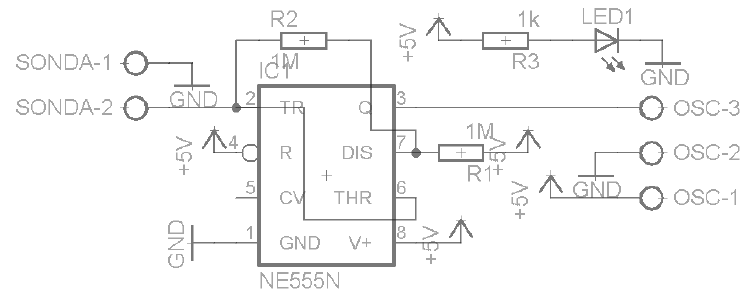
Figure 9. Circuit oscillator of the second prototype.